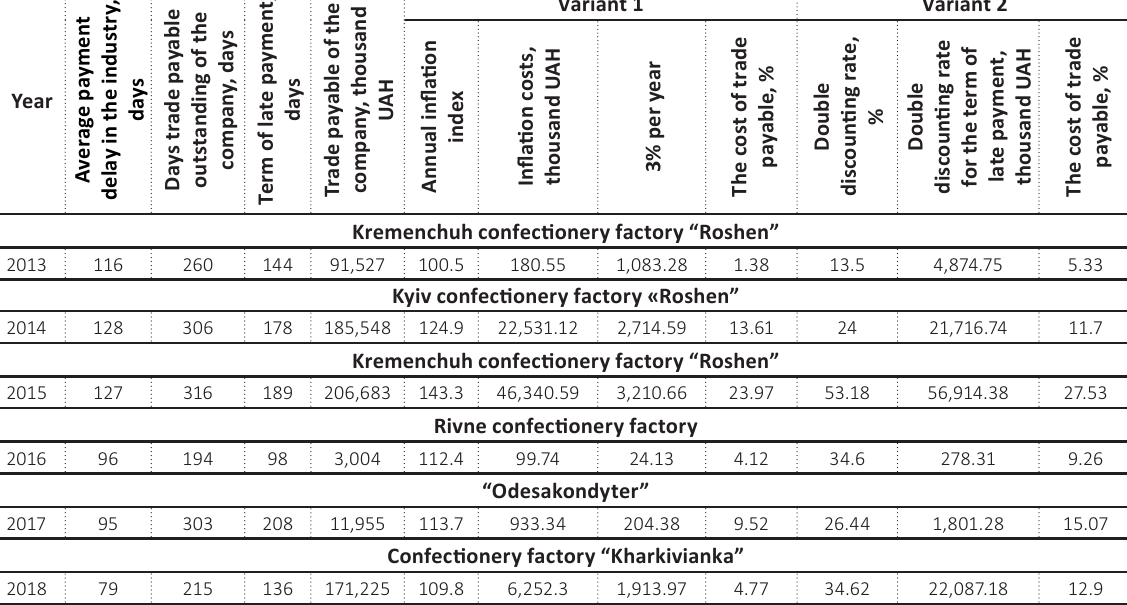
Table 9. Variants of penalties as a cost of trade credit